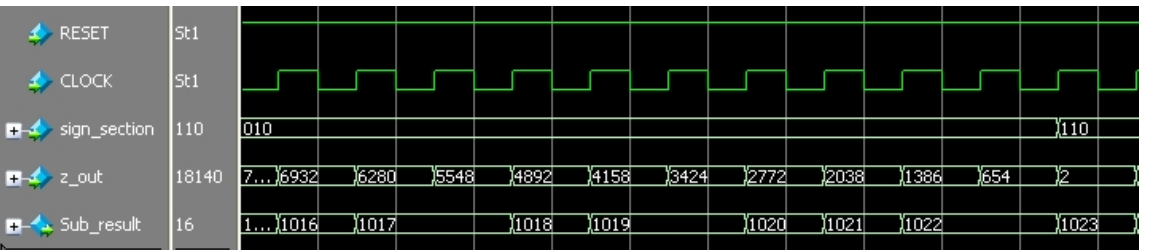
Figure 10. Subdivision circuit simulation test results.